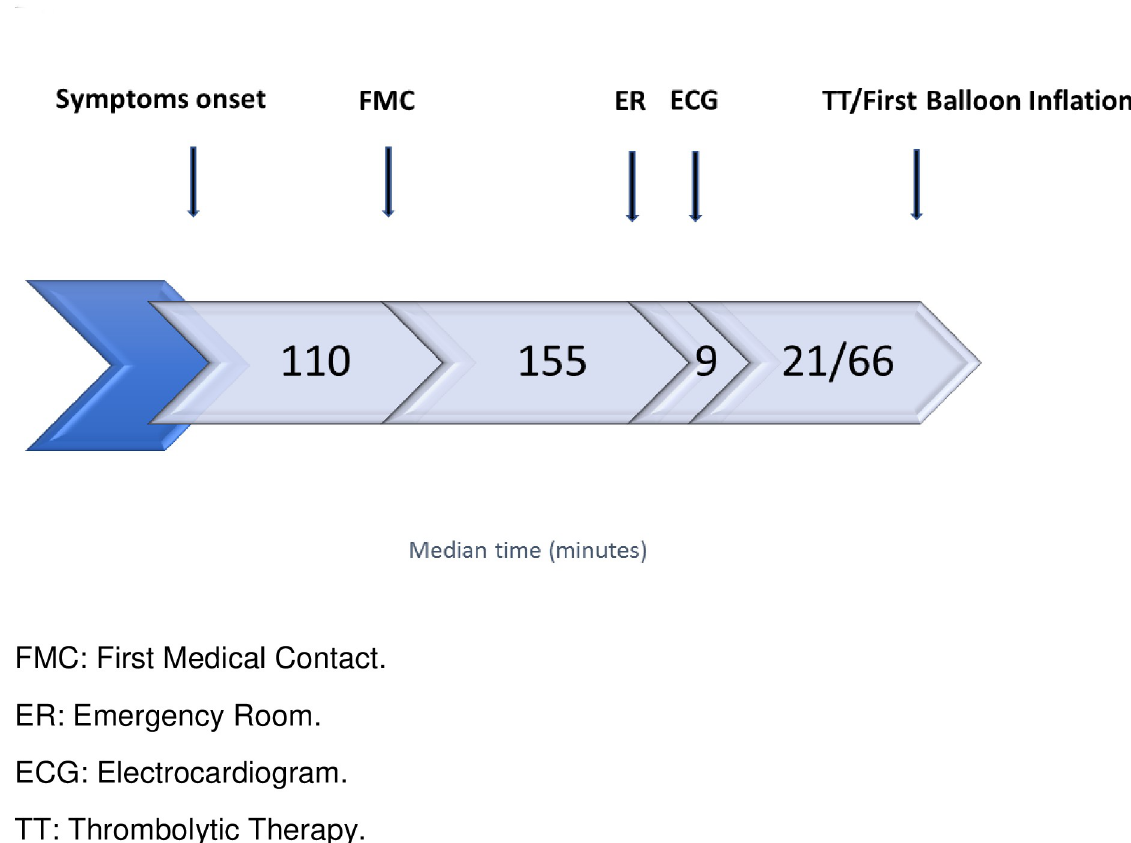
Fig 1. Time-line of patients with ST-segment elevation myocardial infarction. FMC: First medical contact; ER: emergency room; ECG: electrocardiogram; TT: thrombolytic therapy.